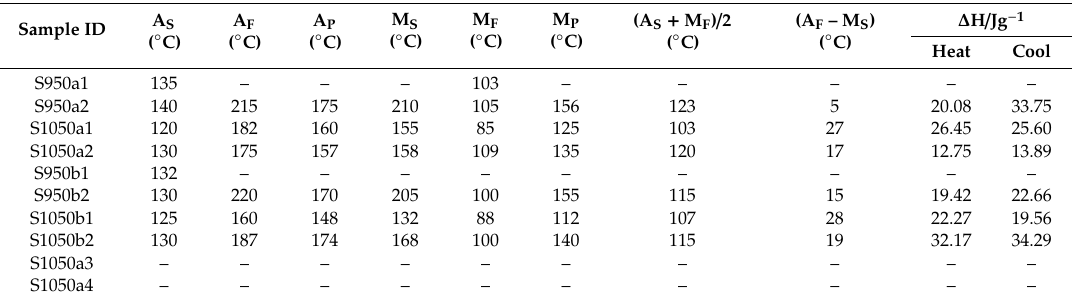
Figure 8. BSE micrographs of Ni 45 Co 5 Mn 40 Sn 10 alloy: ( a ) S1050a1; ( b ) S1050a2; ( c ) S1050b1; and ( d ) S1050b2. Table 4. Transformation and hysteresis temperatures obtained from di ff erential scanning Table 5. Composition of regions in the microstructures of the S1050a1, S1050a2, S1050b1, and S1050b2. calorimetry